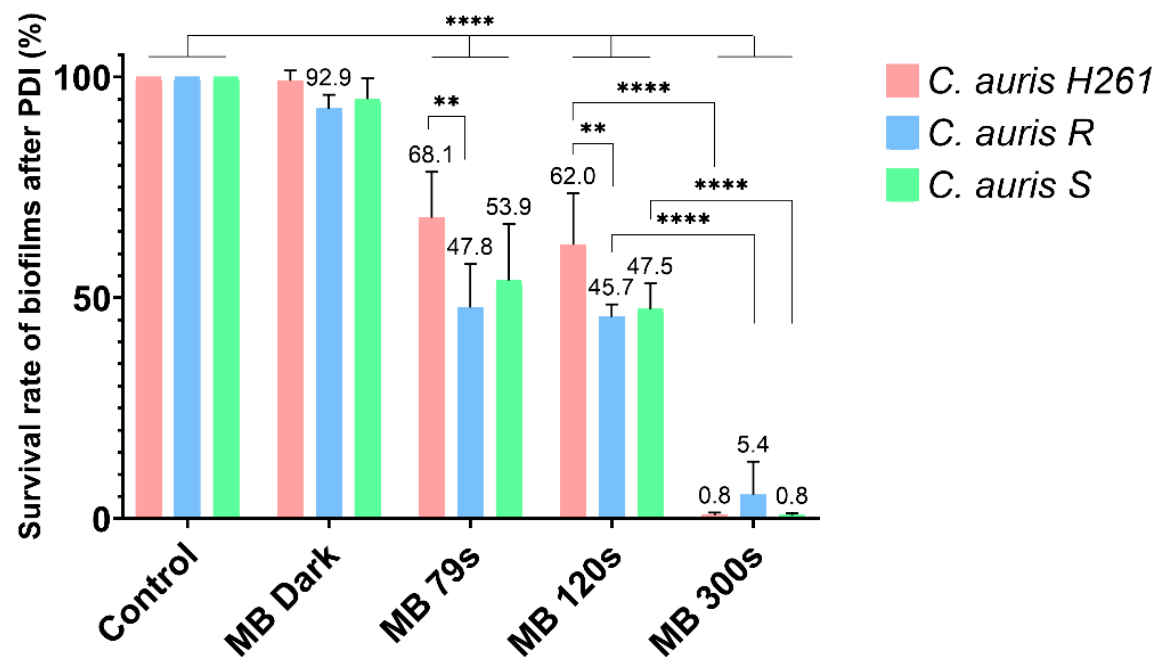
Figure 1. Killing effect of PDI on C. auris H261, C. auris R, and C. auris S. The control group represents a 24 h biofilm without MB; the MB Dark group was incubated with 1 mM MB for 1 h. The MB 79 s, MB 120 s, and MB 300 s groups were irradiated for different periods after the initial 1 h pre-incuba- tion. The results were considered to be significant at different p -values: p < 0.05 ( ∗ ), p < 0.01 ( ∗∗ ), p < 0.001 ( ∗∗∗ ) and p < 0.0001 ( ∗∗∗∗ ).